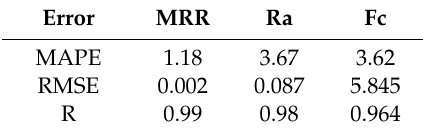
Table 8. Absolute percentage error (MAPE), root mean squared error (RMSE), and correlation coe ffi cient